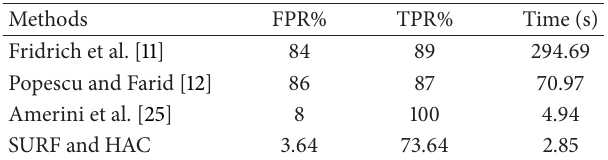
Table 1: TPR, FPR values (%) and processing time (average per image) for each method.